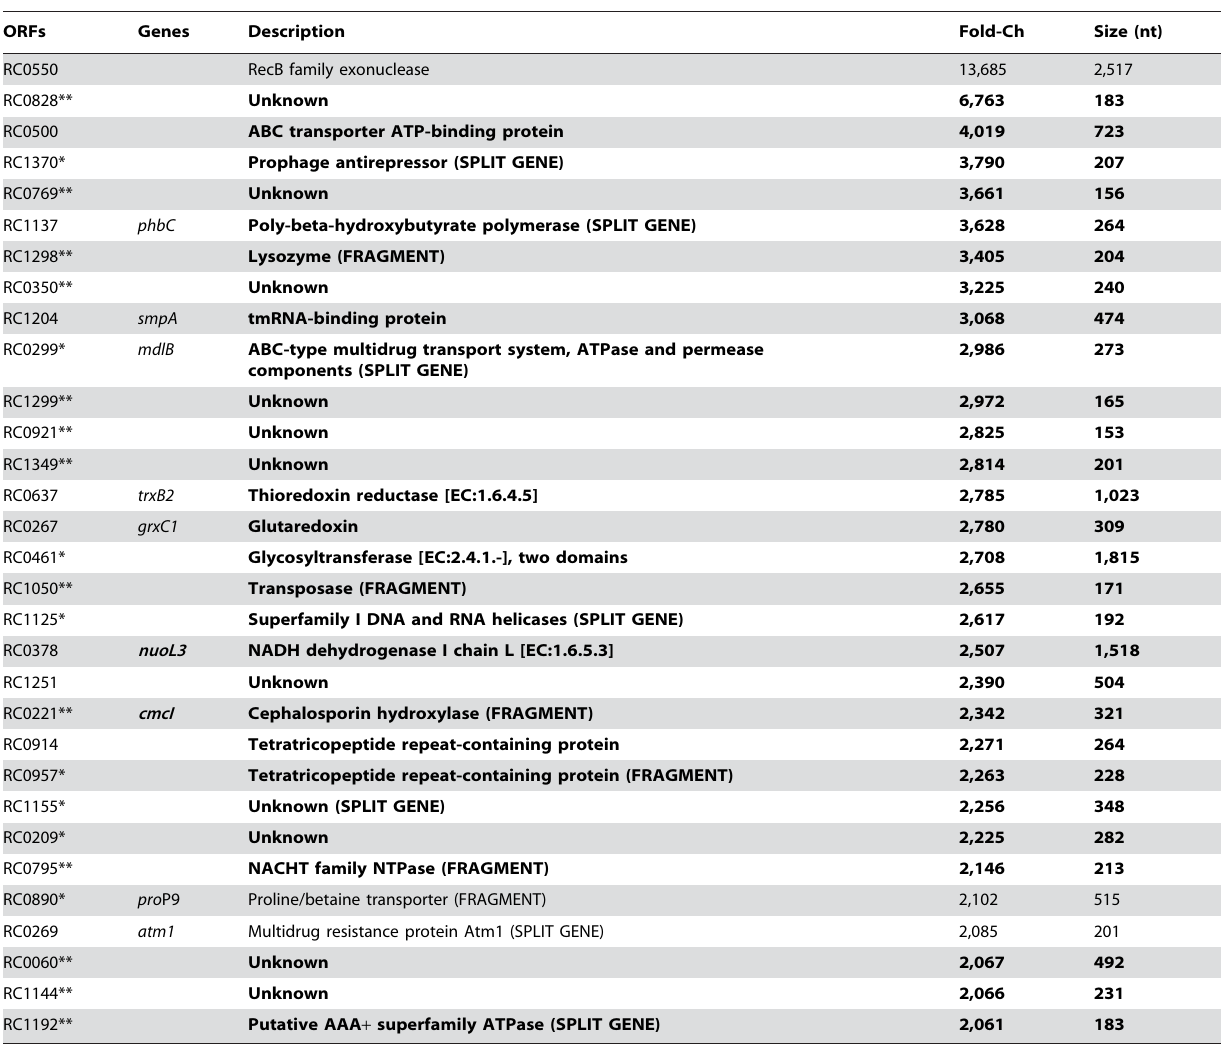
Table 2. Thirty one genes of R. conorii up-reguled within